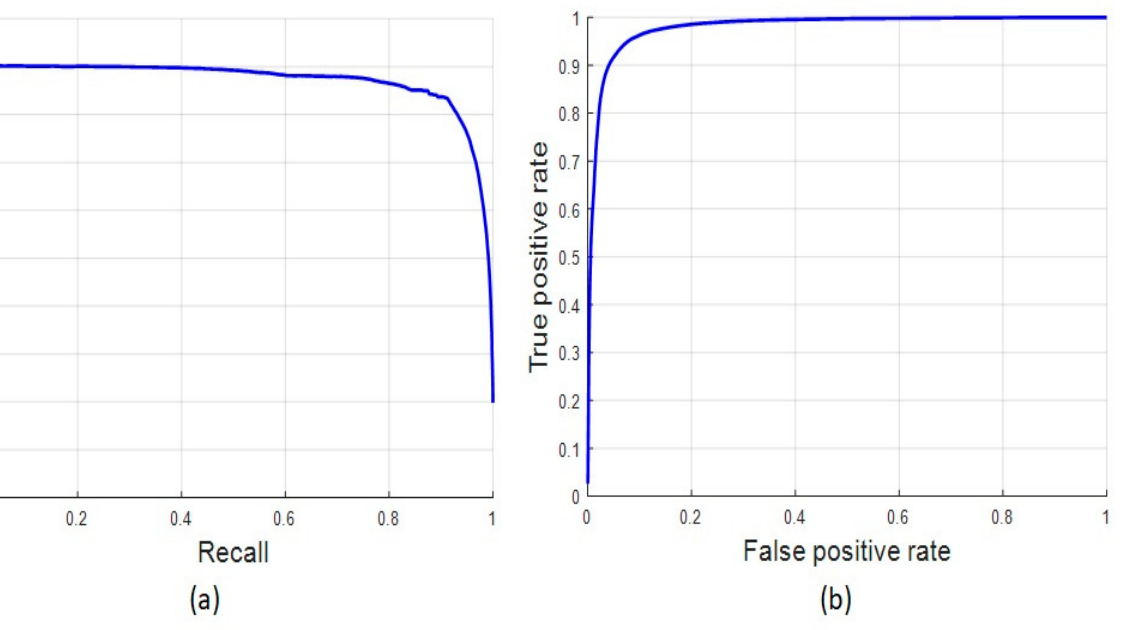
Figure 8. Learning curve of the proposed framework illustrating percentage of accuracy versus number of iterations. In the second part of the experiment, the competency of the proposed transfer learning-based DCNN framework is compared with existing brain tumor classification techniques on the Figshare dataset. We consider some of the existing methods introduced by researcher Ismael et al. [3], Abiwinanda et al. [7], Swati et al. [16], Afshar et al. [29], and Pashaei et al. [39], for the comparison. Ismael et al. [3] combined both statistical fea-